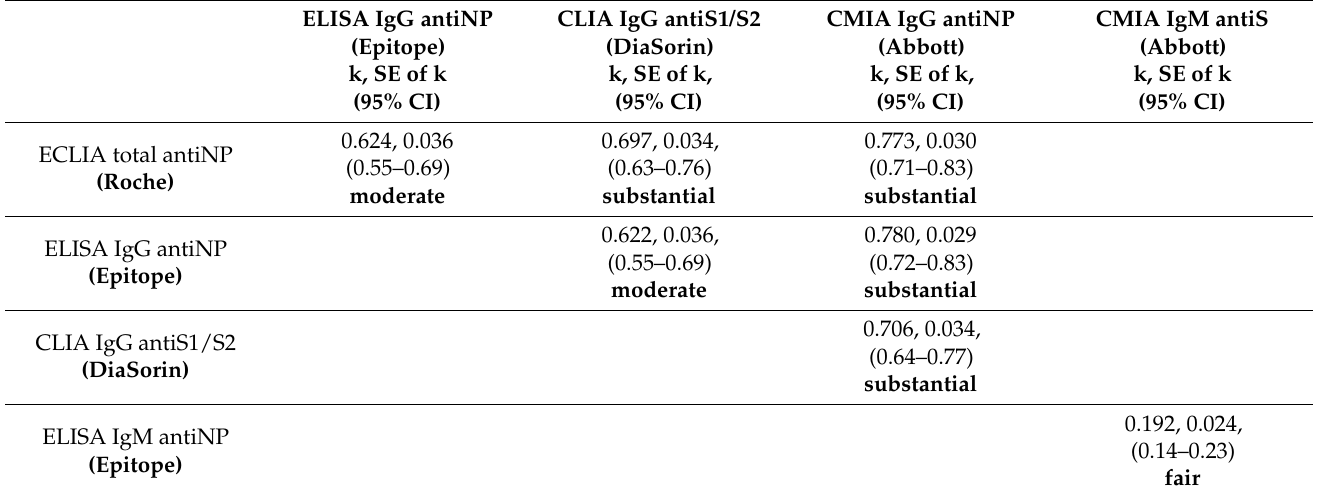
Table 5. Agreement between the evaluated assays (528 samples) (95% confidence